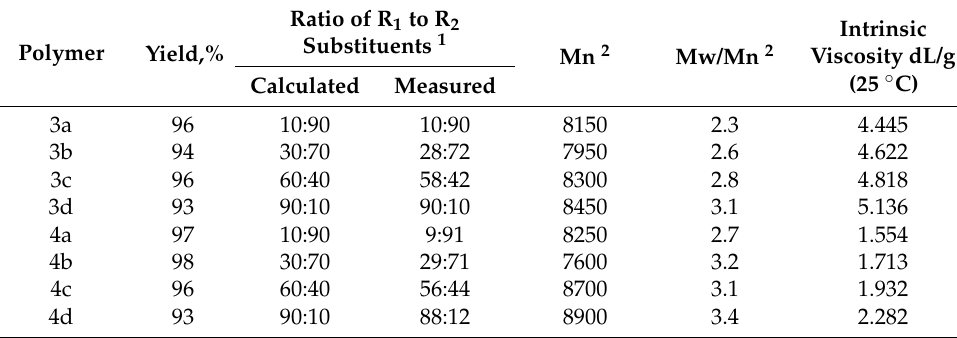
Table 1. Composition and molecular weights of silatrane-containing polymers.